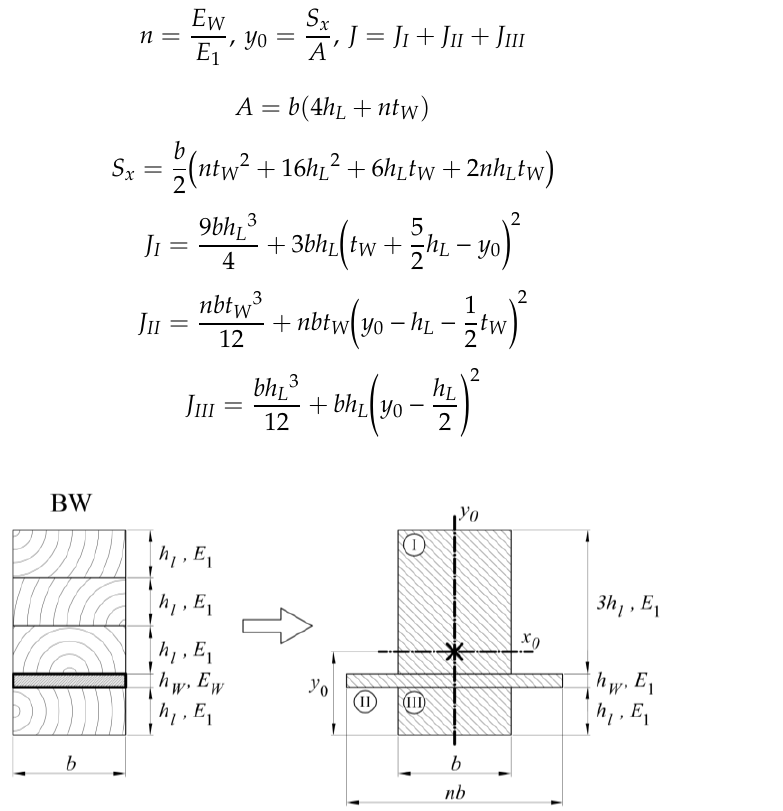
Figure 22. Cross-section of BW-type samples, including the parameter notation used in the text.